Question: Draft a figure caption describing what is shown.
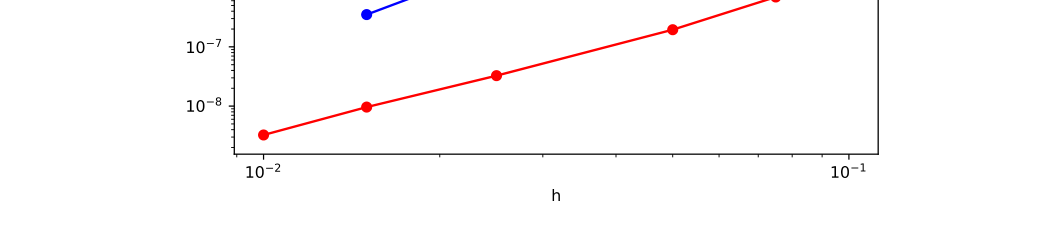
Answer: 2: Here, we can see the residual error of the multiplicative and additive Schwarz method for the nonlocal Dirichlet problem with a singular symmetric kernel regarding diﬀerent choices for the mesh resolution h. In all cases the error decreases in a linear fashion, which we expected at least for the multiplicative Schwarz version due to Remark 5.3. Moreover, the additive version needs roughly twice as many iterations as the multiplicative Schwarz algorithm.